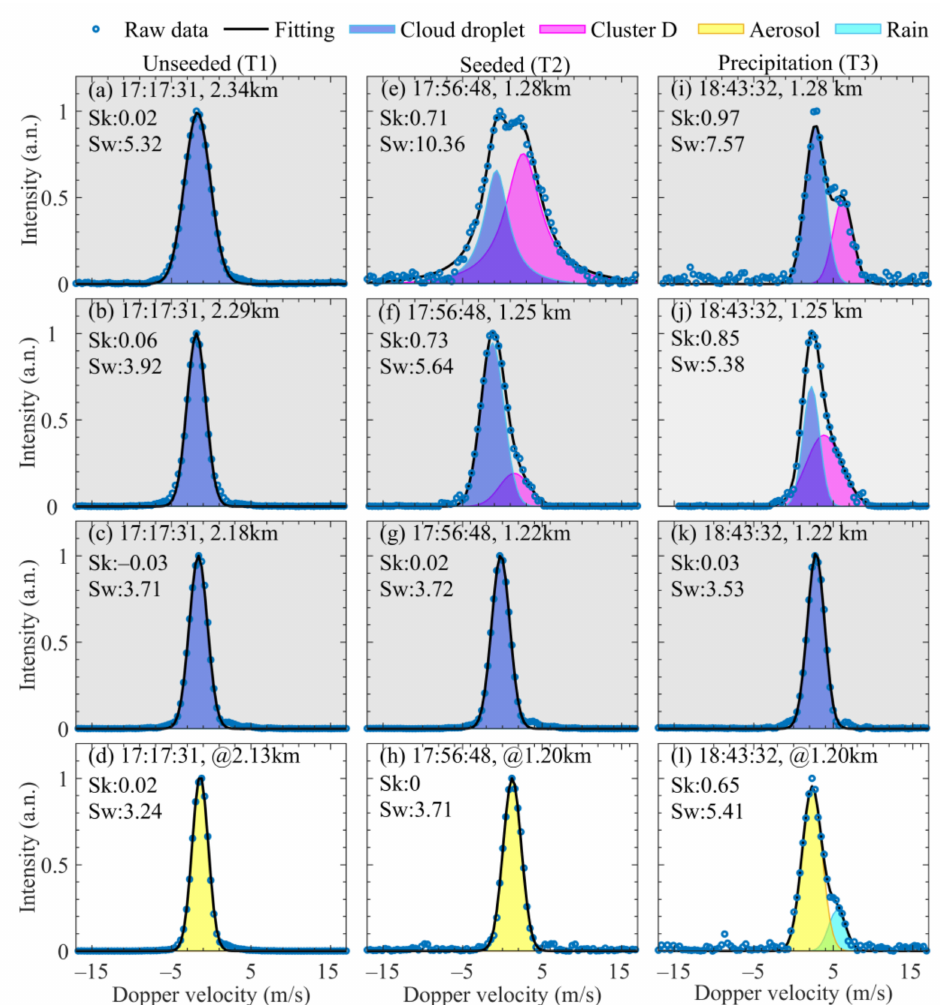
Figure 9. Examples of cloud spectra from cloud middle to cloud base. ( a – c ) show cloud spectra of unseeded at T1 (5:17 p.m.); ( e – g ) show cloud spectra of after seeded at T2 (5:56 p.m.); ( i – k ) show cloud spectra at T3 (6:43 p.m.), when precipitation formed. ( d , h , l ) are aerosol or precipitation spectra below cloud base. Circles stand for the raw data of spectra. Black lines represent fitting results. The light purple shadow and pink shadow represent separated cloud droplet and cluster D, respectively. The yellow shadow and light blue shadow represent separated aerosol and rain components,